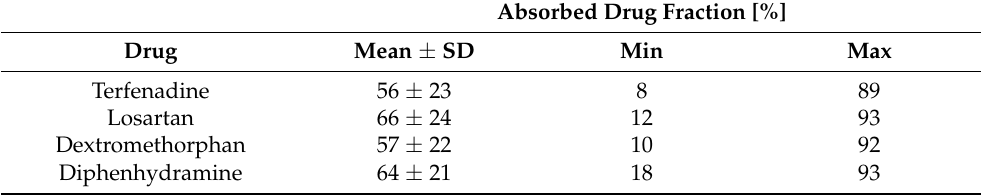
Table 1. The absorbed fraction of the four different drugs. The drug abundance of the tissue was extracted from the combined blue and red clusters seen in the spatial clustering. The data is presented as mean ± SD and range of all analyzed specimens. The individual values for each specimen can be found in Supplementary Figure